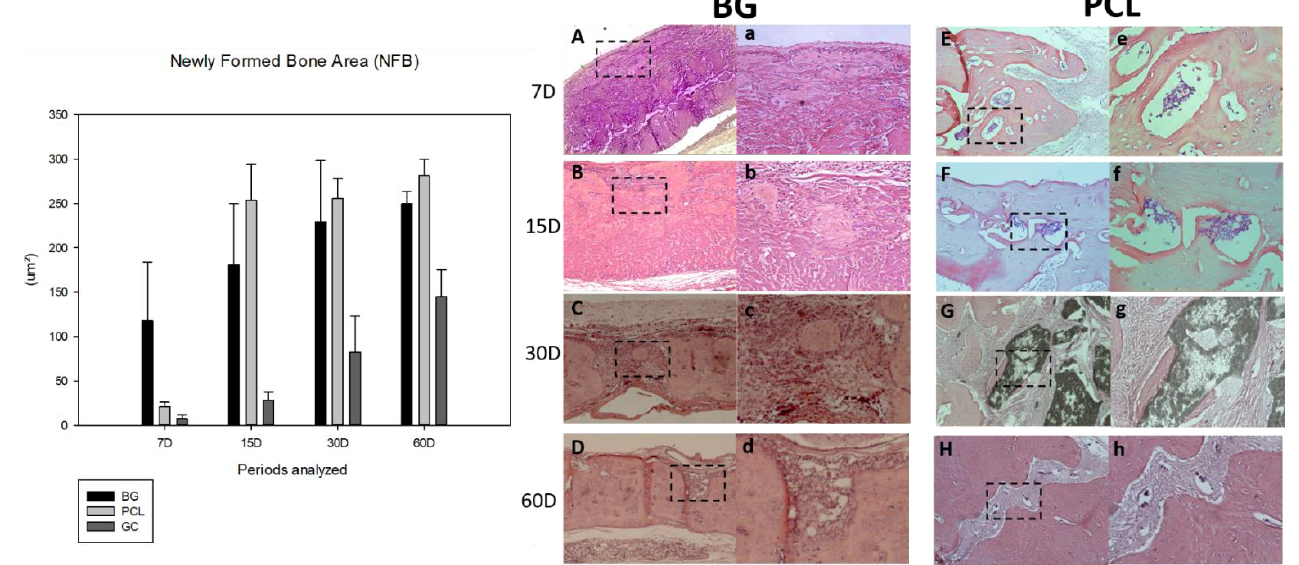
Figure 4. Graph and representative photomicrographs comparing the areas of bone neoformation between the groups and periods analyzed. Comparing the membranes used, there was no statistically significant difference between the PCL and BG groups ( p = 0.799). The factor time, mainly at the initial periods, is critical for better results. For the BG group at 7 ( A ), 15 ( B ), 30 ( C ), and 60 ( D ) days (×12.5): A. Panoramic image of newly formed bone near the periosteum. B. Panoramic image of osteoid tissue islands at the center of the defect. C. Panoramic image of the center of the defect almost closed with immature bone tissue. D. Panoramic image of the center of the defect. a , b , c , and d are higher magnifications (×25) of the panoramic views. For the PCL group (×12.5): E. Panoramic image of the osteoid tissue around a polycaprolactone particle near the stump. F. Panoramic image of the osteoid tissue around a polycaprolactone particle near the center of the defect. G. Panoramic image of a large polycaprolactone particle with mature osteoid tissue. H. Panoramic image of the center of the defect with a remaining particle of polycaprolactone. e , f , g , and h are higher magnifications (×25) of the panoramic views. In short, PCL = BG > CG.